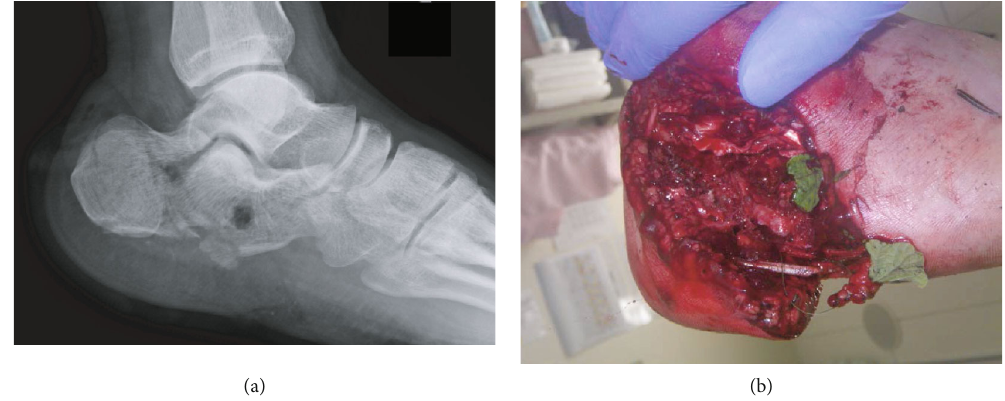
Figure 2: (a) Lateral view of the initial radiograph revealed a tongue-type calcaneus fracture. (b) Severe contamination by standing water of a 10cm wound on the lateral side of the calcaneus; small leaves were attached to the wound.